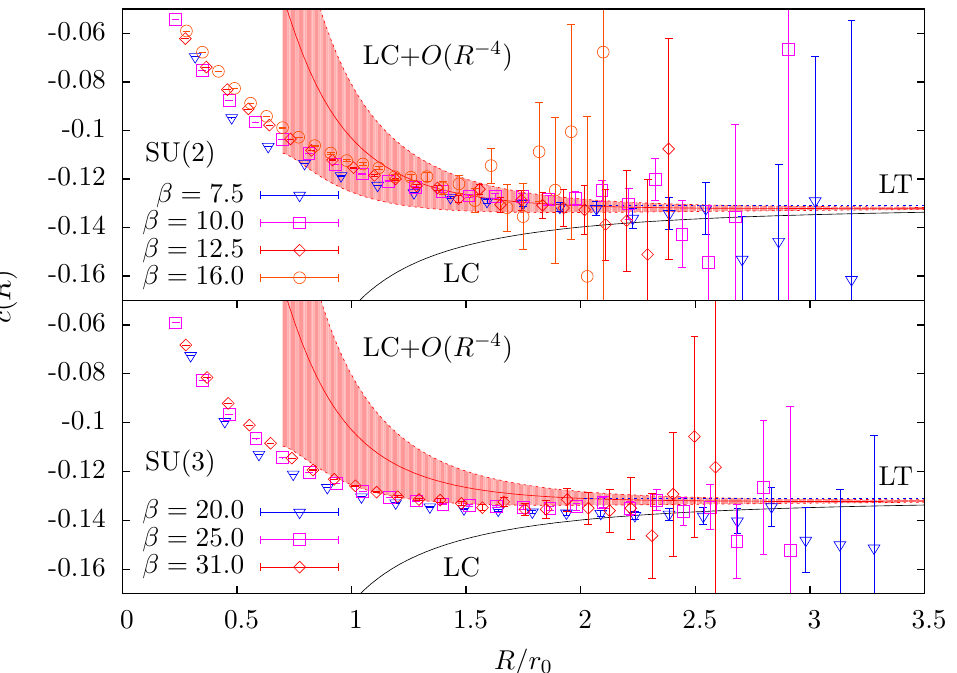
Figure 8 . Results for the curvature c ( R ) plotted versus R=r 0 . The curve labeled with ‘LT’ is the L(cid:127)uscher constant, the one labeled with ‘LC’ is the light cone potential with the continuum extrapolated string tension and the curve labeled with ‘LC+ O ( R (cid:0) 4 )’ is the LC curve including the boundary term with the continuum extrapolated value of (cid:22) b 2